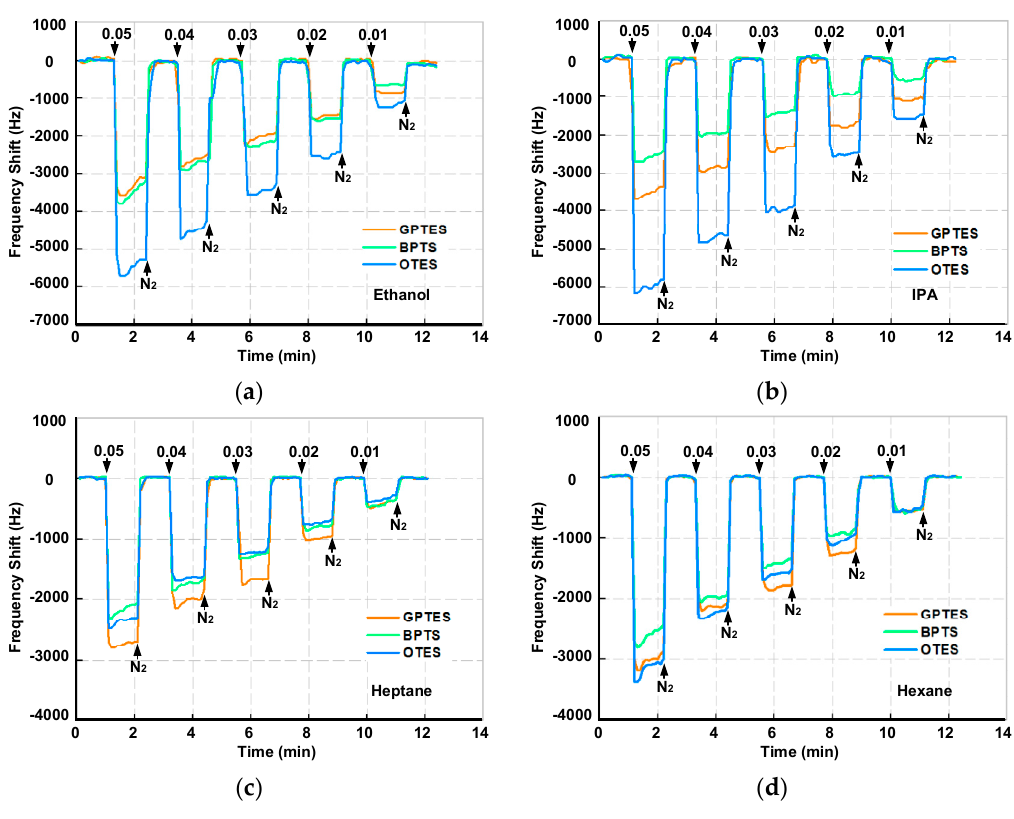
Figure 4. Real-time responses of the PSBAR gas sensor array to ( a ) ethanol, ( b ) IPA, ( c ) heptane and ( d ) hexane.